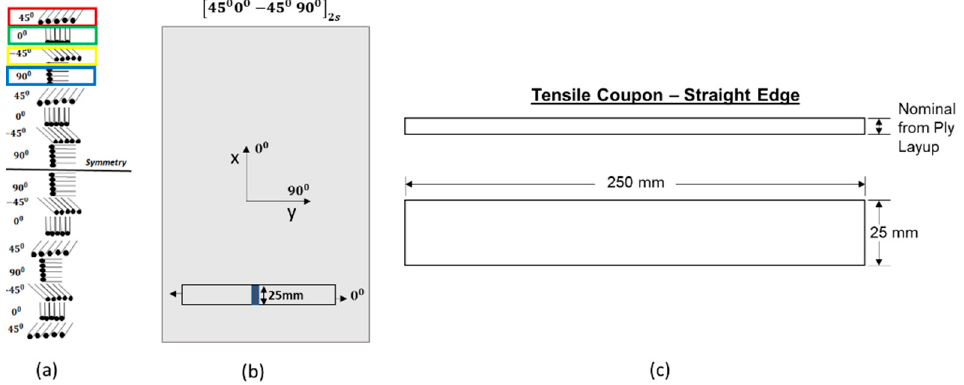
Figure 3. ( a ) Schematic of the IM7/8552 laminate fiber orientation stacking, ( b ) schematic of specimen orientation in relation to the manufactured composite sheet, and ( c ) straight edge specimen of IM7 8552 used for experimental testing in this